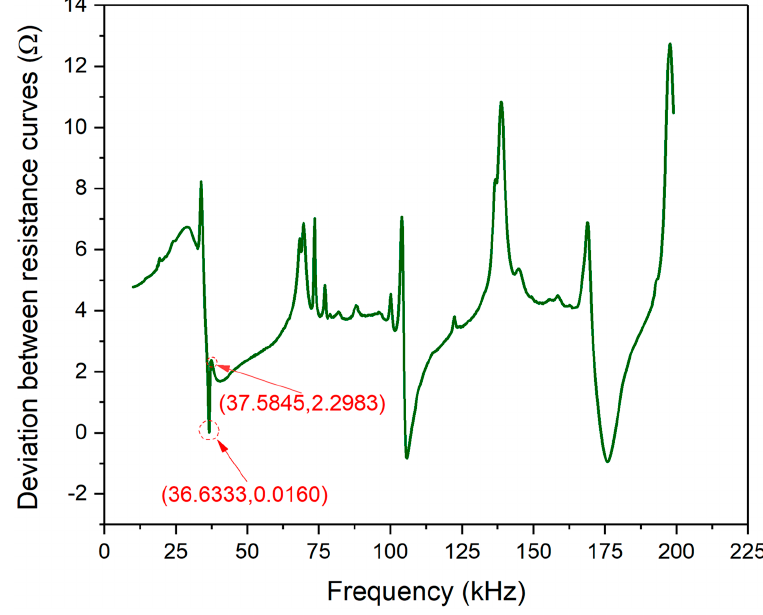
Figure 6. Resistance signal deviation between experimental and theoretical curves of PZT#1.